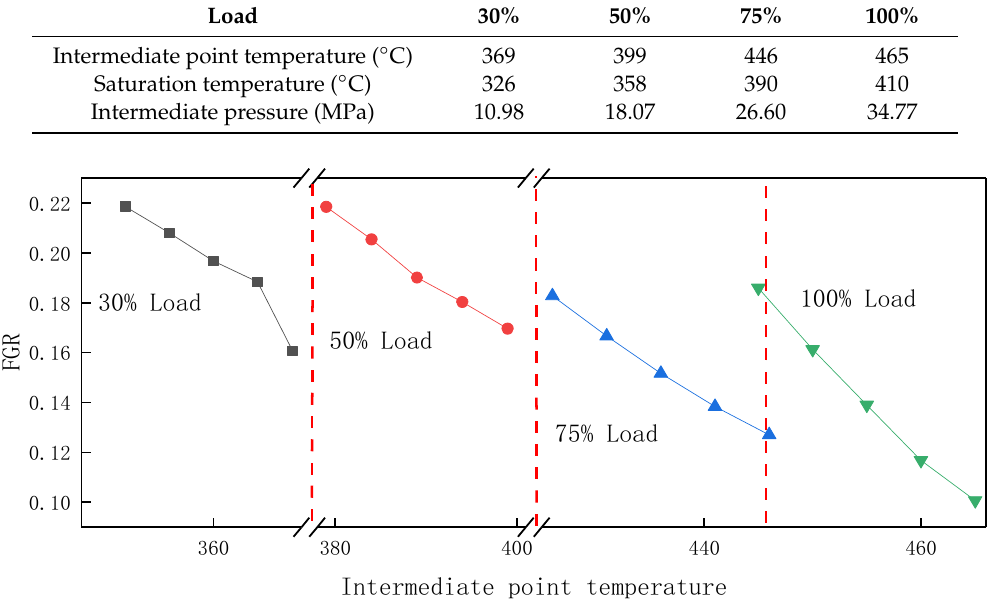
Table 5. Parameters of reference system under four loads. Load